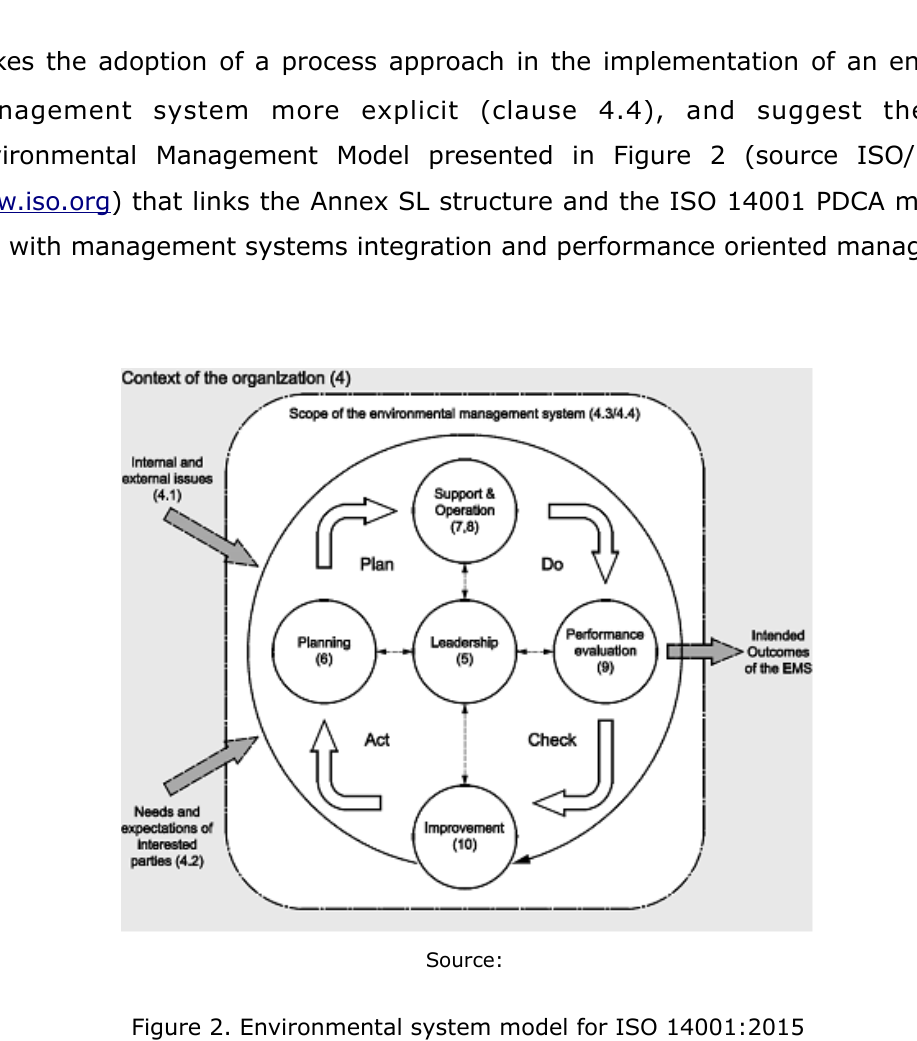
Figure 2. Environmental system model for ISO